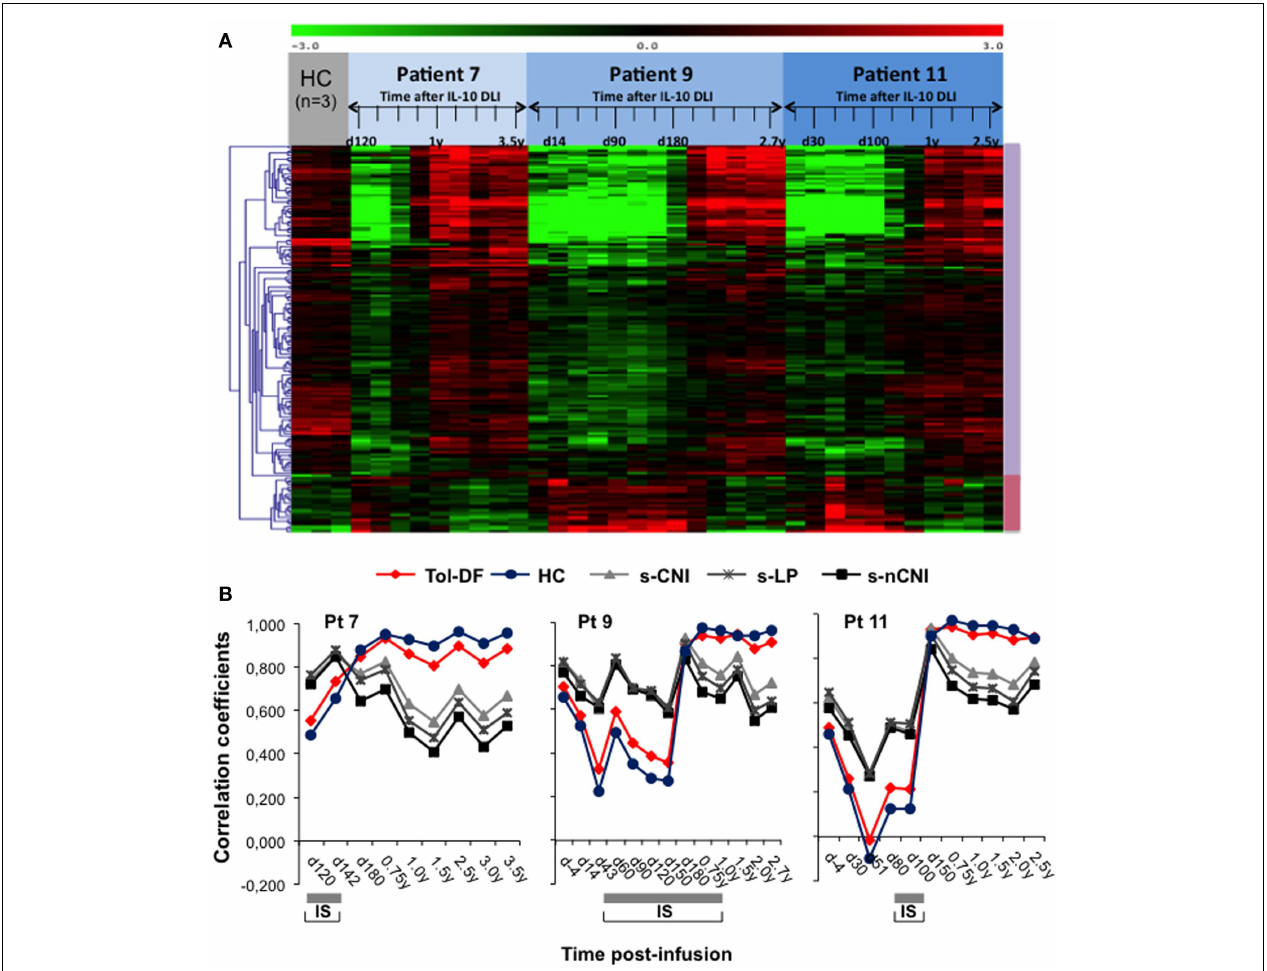
within the Indices ofTolerance (IOT) study in patients 7, 9, and 11. Pairwise Pearson correlation coefficients comparing the medians of expression in each IOT patient group (Tol-DF: tolerant drug-free; s-CNI: stably immunosuppressed by calcineurin inhibitors (CNI); s-nCNI: stable under non-CNI; s-LP: stable under low dose prednisolone; HC: healthy controls) with the expression in each separate time-point sample from patients 7, 9, and 11 are shown.The expression of the most discriminatory IOT biomarkers in IL-10-DLI treated patients progressively became super-imposable to that in Tol-DF patients and HC.The gray bars below each graph indicate immunosuppressive